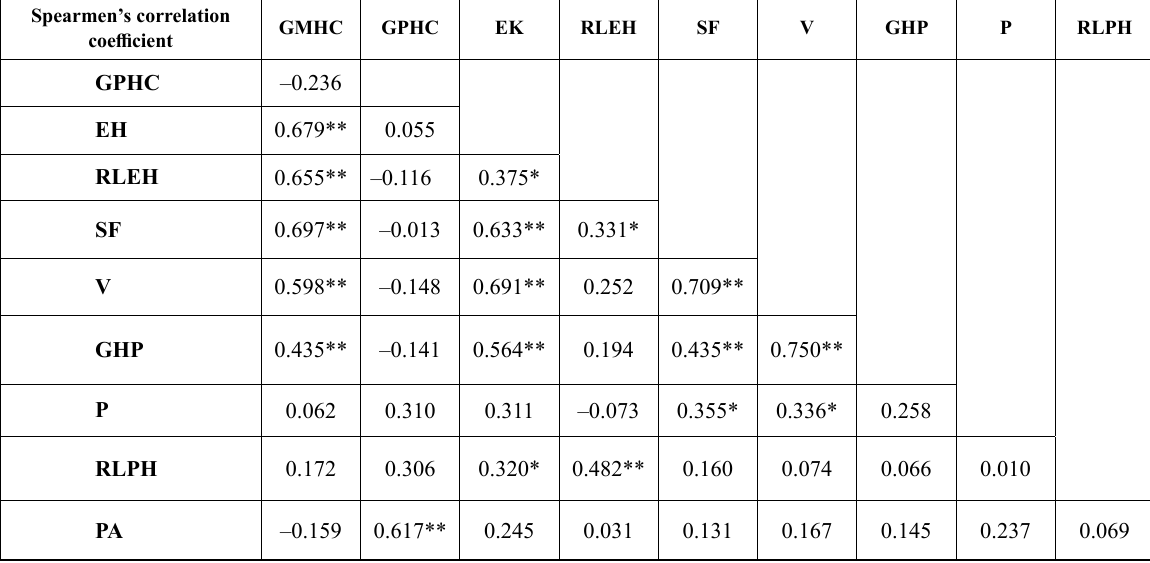
Table 2. Relationship between the quality of life domains Spearmen’s correlation